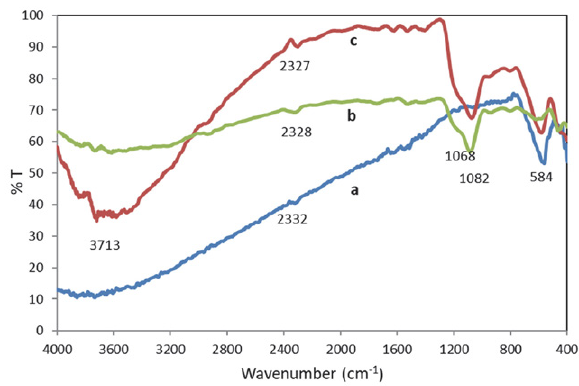
Figure 3. FT-IR spectra of Fe 3 O 4 (a), Fe 3 O 4 @SiO 2 (b) and Fe 3 O 4 @ SiO